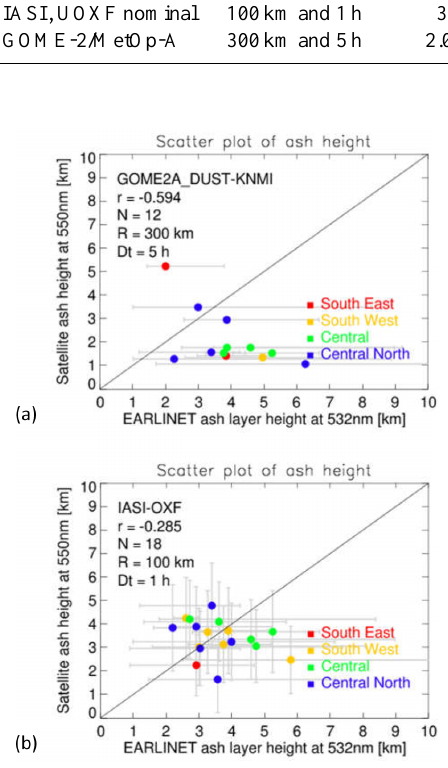
Figure 3. Scatter plots between satellite ash layer height and EAR- LINET ash layer height (in km) for GOME-2A (a) and IASI- UOXF (b)